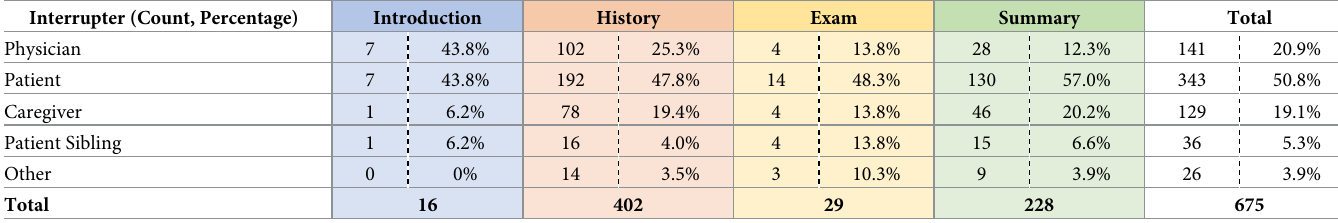
Table 3. Clinic distribution of interrupters.